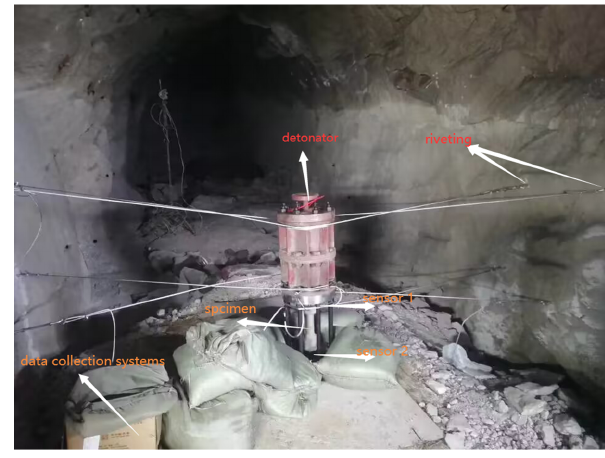
Figure 6. Plane explosion wave experiment sited.